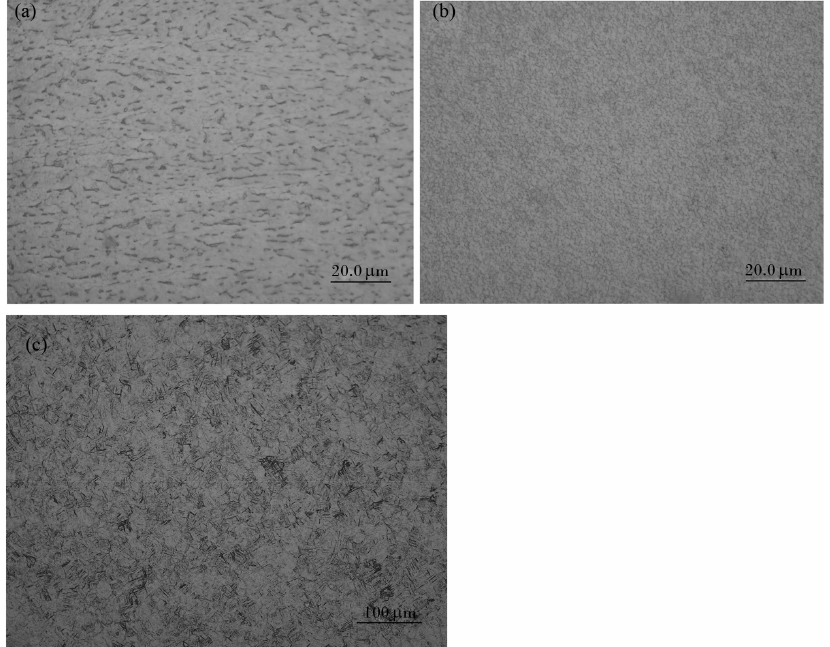
Figure 4: Microstructures of joint under different welding parameters: (a) BM, (b) SAZ at 120 rpm/50mm/min and (c) SAZ at 375